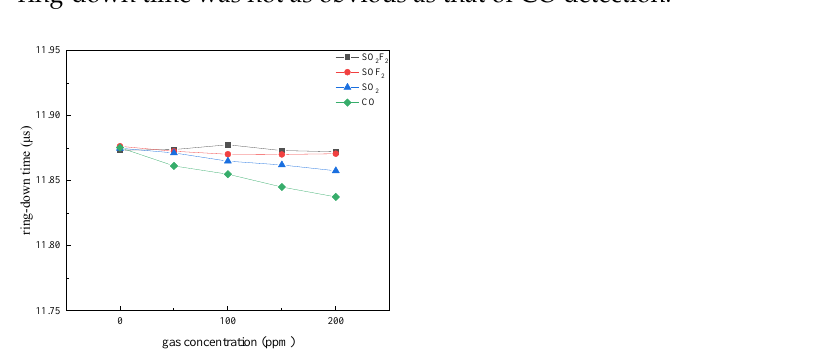
Figure 4. The relationship between gas concentration and ring-down time.